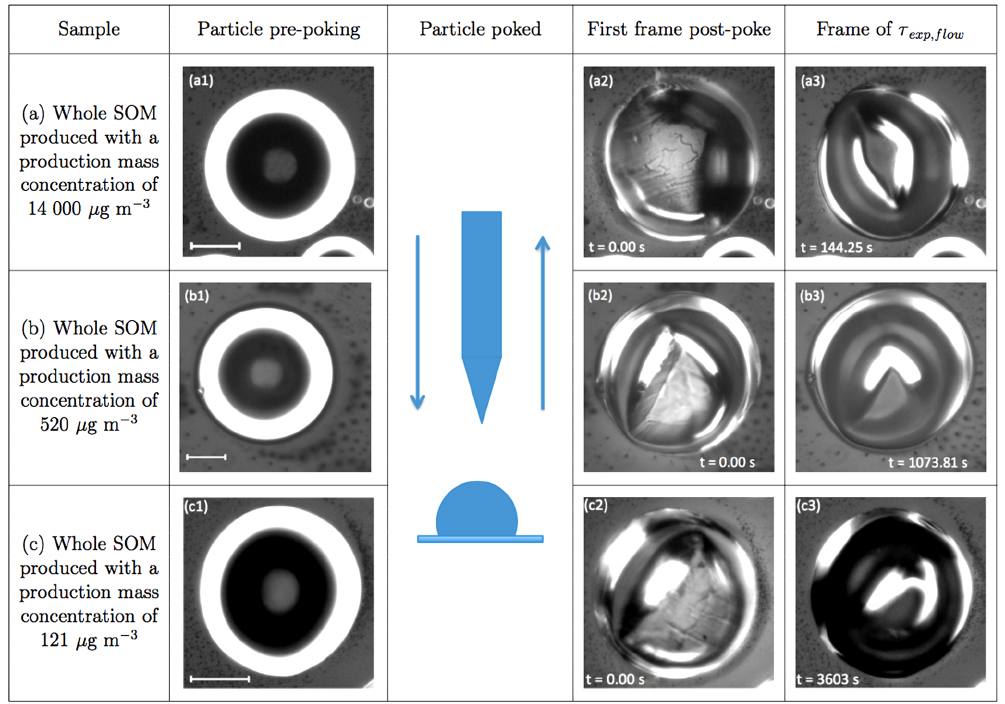
Figure 4. Optical images recorded during typical poke-and-flow experiments of particles of the whole SOM produced at production mass concentrations of (a) 14000µgm − 3 , (b) 520µgm − 3 , and (c) 121µgm − 3 being poked at <0.5% RH. Panels (a1) , (b1) and (c1) correspond to SOM prior to poking. Panels (a2) , (b2) and (c2) correspond to the first frame post-poke (i.e. the first frame after the needle has been removed). Panels (a3) , (b3) and (c3) correspond to images of the experimental flow time, τ exp, flow , the point at which the diameter of the hole at the centre of the torus has decreased to 50% of its original size. Scale bar in panels (a1) , (b1) and (c1) :